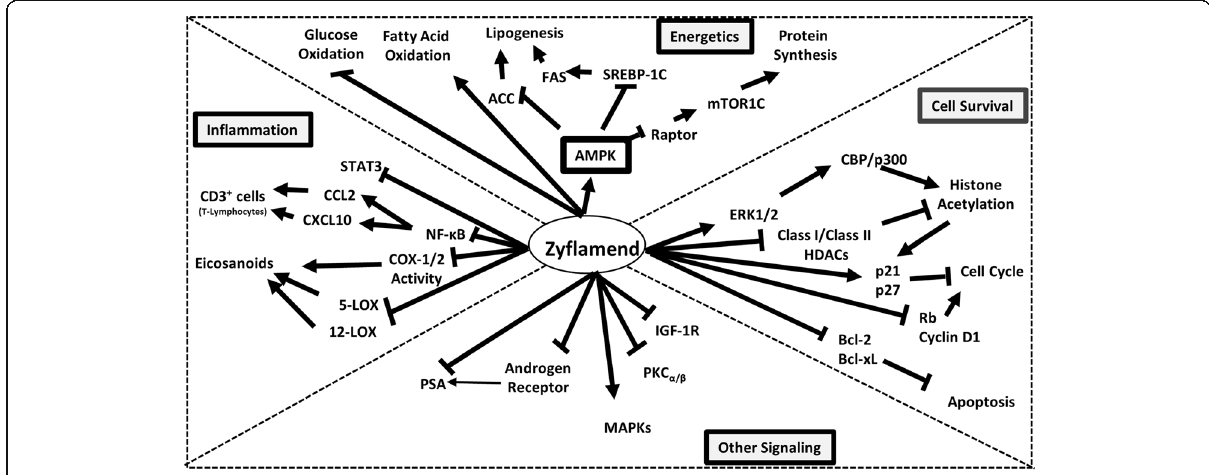
Fig. 1 Summary of the effects of Zyflamend on prostate cancer (with permission from reference